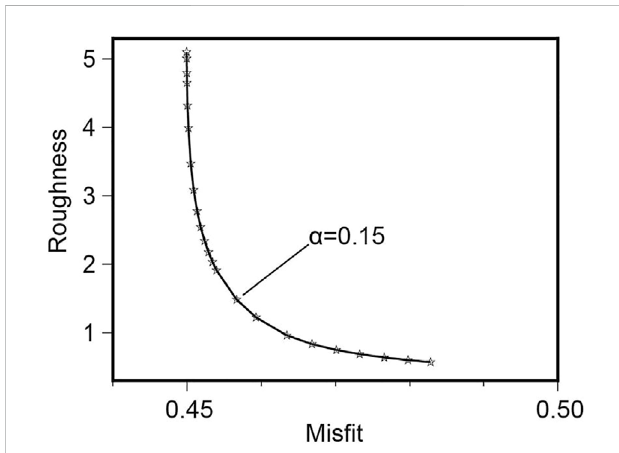
Trade-off curve between mis fi t and model roughness. The roughness values are normalized. The plus symbol corresponds to where the balance between the model mis fi t and smoothness is achieved, a smooth factor of 0.15 used for estimating the slip